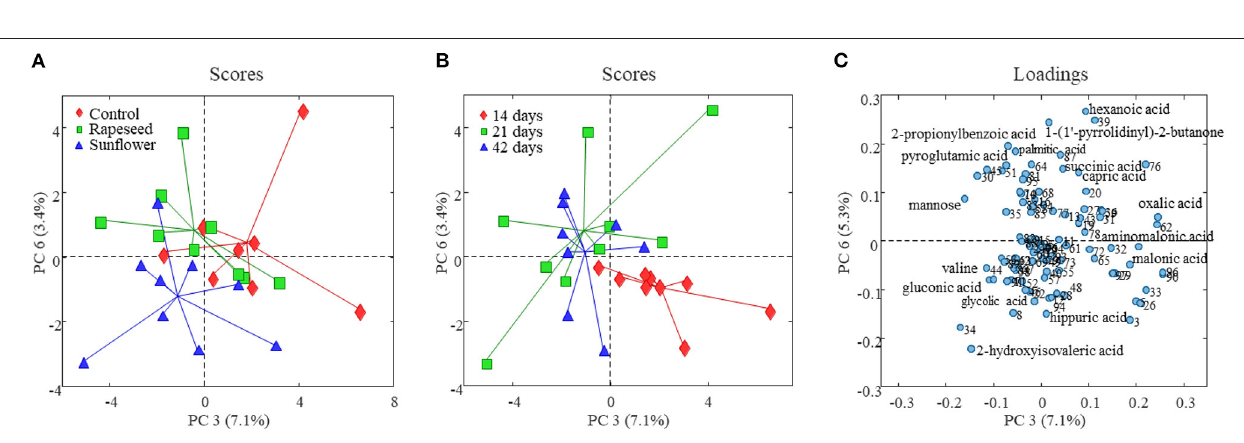
FIGURE 2 | Score and loading plots of the PCA model developed on goat milk GC-MS foodomics data. (A) PC3 vs. PC6 score plot and milk samples are color coded according to the dietary treatment, and in panel (B) , milk samples are colored according to the experimental period. (C) PC3 vs. PC6 loading plot from the corresponding PCA model (variables are numbered as in Supplementary Table S1